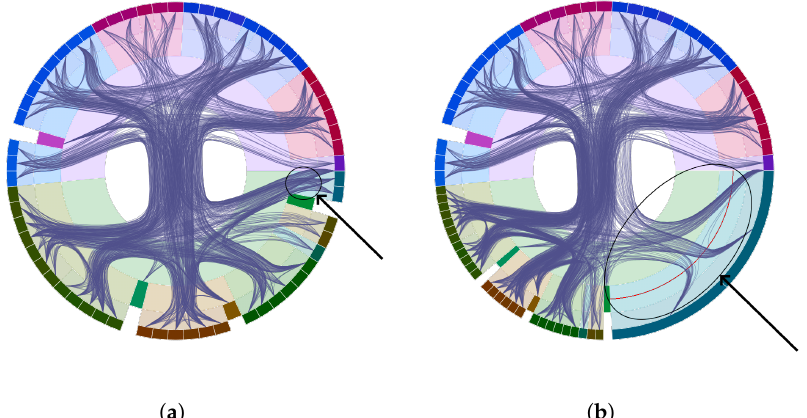
Figure 8. The magnification of a sector increases or decreases its angle by readjusting the space associated with its sibling nodes. ( a ) The arrow points to the sector to be magnified. ( b ) The red arc crossing the sector indicates that its size is modified by a magnification operation and therefore does not faithfully reflect the angle computed according to the properties of the data.